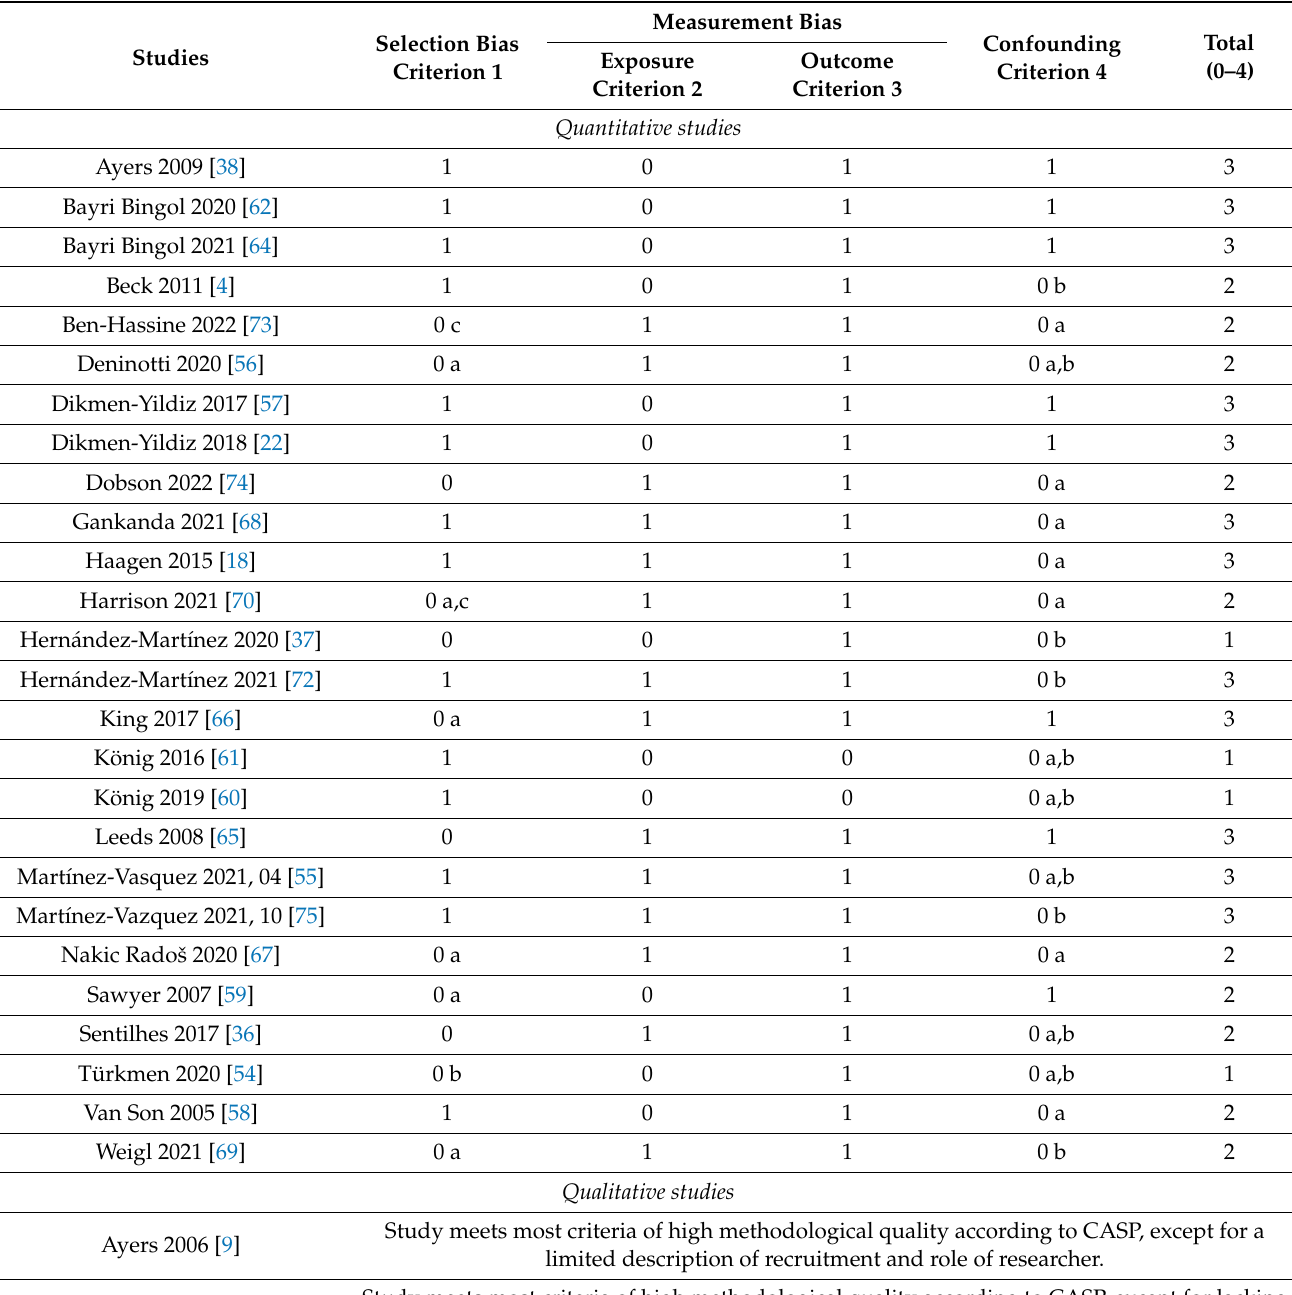
Table 2. Quality assessment of the included studies using the Critical Appraisal Skills Programme (CASP)